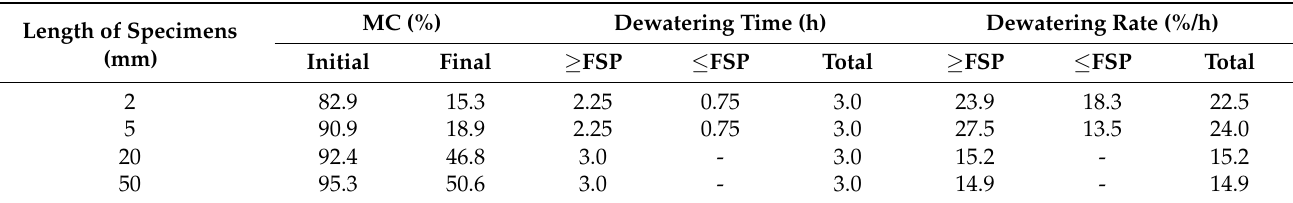
Figure 3. ( a ) Dewatering curves of Eucalyptus urophylla specimens with a hold time of 15 min, a temperature of 35 °C, and a pressure of 20 MPa. ( b ) Final average MCs of specimens after 12 dewatering cycles. The error bars in are the mean square errors of the five specimens, indicating their MC deviation after each cycle of dewatering. Table 2. The initial and final MCs, dewatering times, and dewatering rates of specimens with lengths of 2, 5, 20, and 50